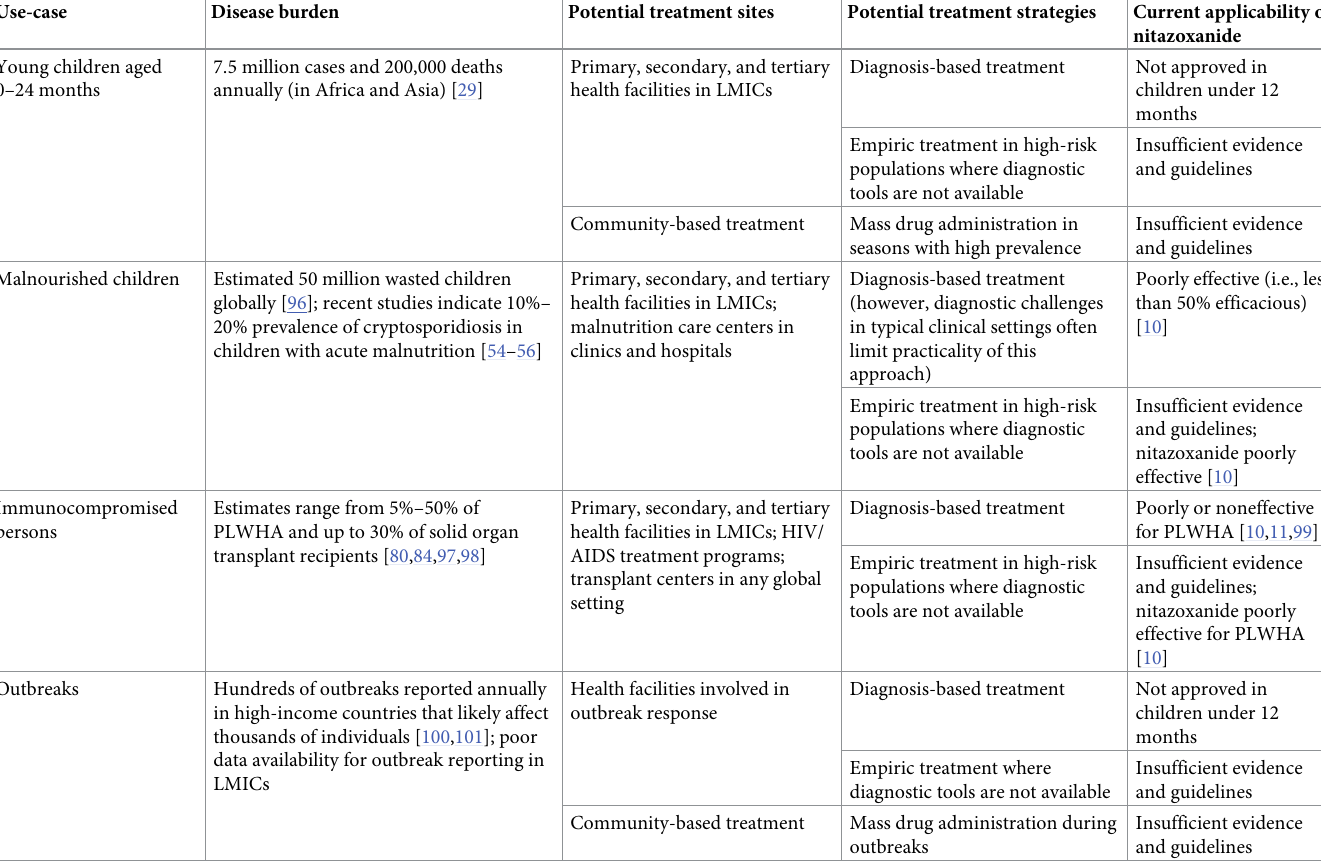
Table 2. Summary of use-case scenarios for an anti- Cryptosporidium therapeutic.